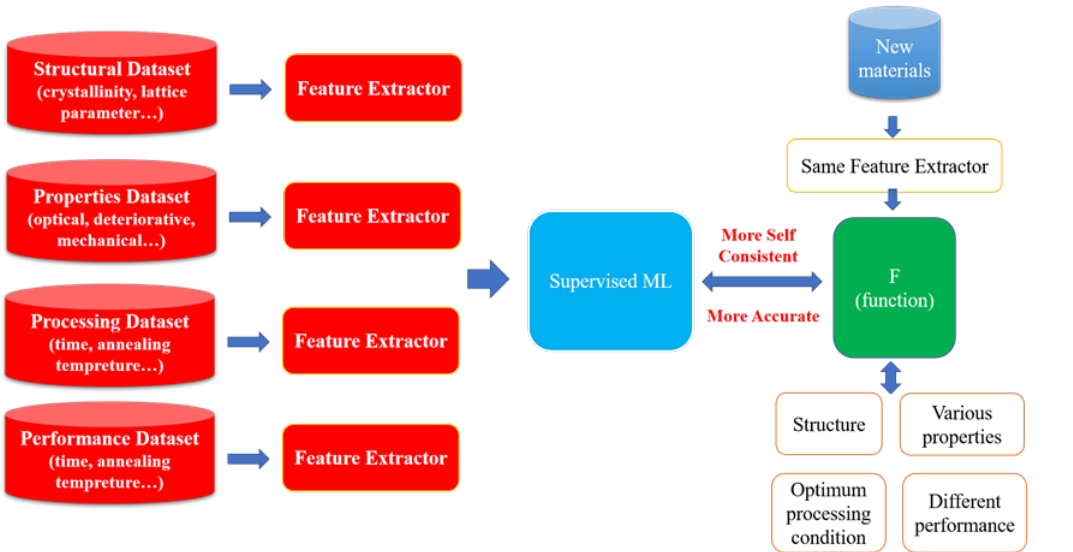
Figure 10. Basic strategies for combining structures, properties, processing, and performance via machine learning.